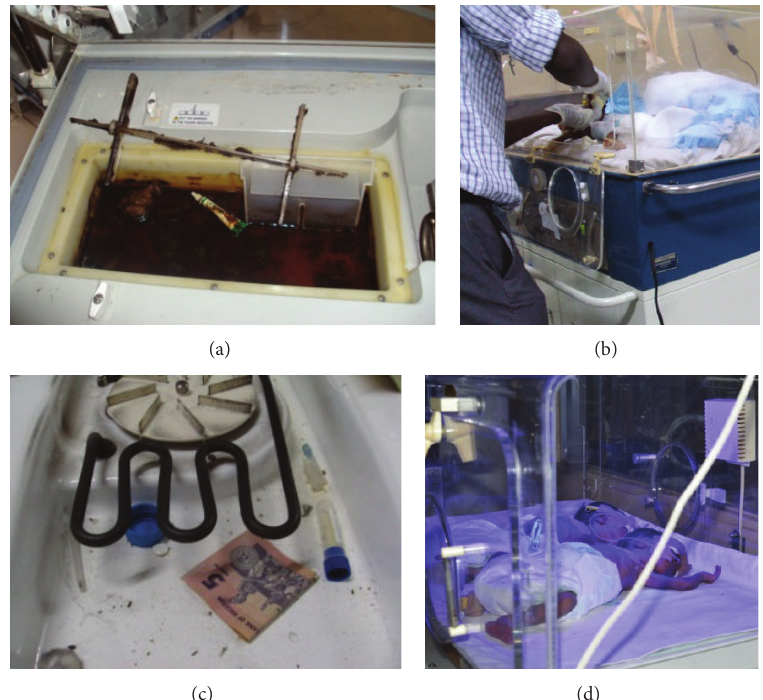
Figure 2: Few observable incubator bad practices. (a) A filthy humidifier chamber that had never ever been drained of water or cleaned. (b) Clinician using an operating incubator as a work bench for a very long procedure. (c) All sorts of materials left and concealed within a functioning incubator. (d) Multiple neonates sharing the same incubator.